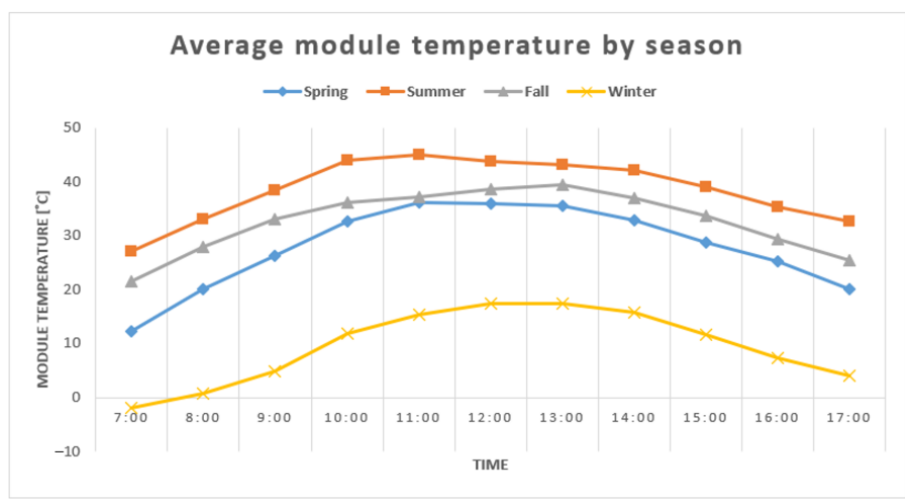
Figure 5. Characteristics of season-basis solar radiation.